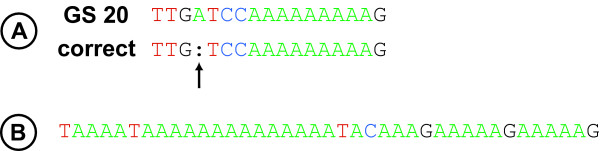
Illustrations of a transposition-like insertion error and a homopolymer run set. (A) Comparison of a hypothetical stretch of GS 20 genome sequence (top) vs. the "correct" sequence (bottom) in order to illustrate an example of a transposition-like insertion error, in which a base identical in composition to a given HR is inserted in a nearby, nonadjacent position. The transposition-like insertion error in the GS 20 sequence is indicated by the arrow; the colon (:) in the "correct" sequence indicates the absence of the A at the same position. (B) Example of a homopolymer run set.